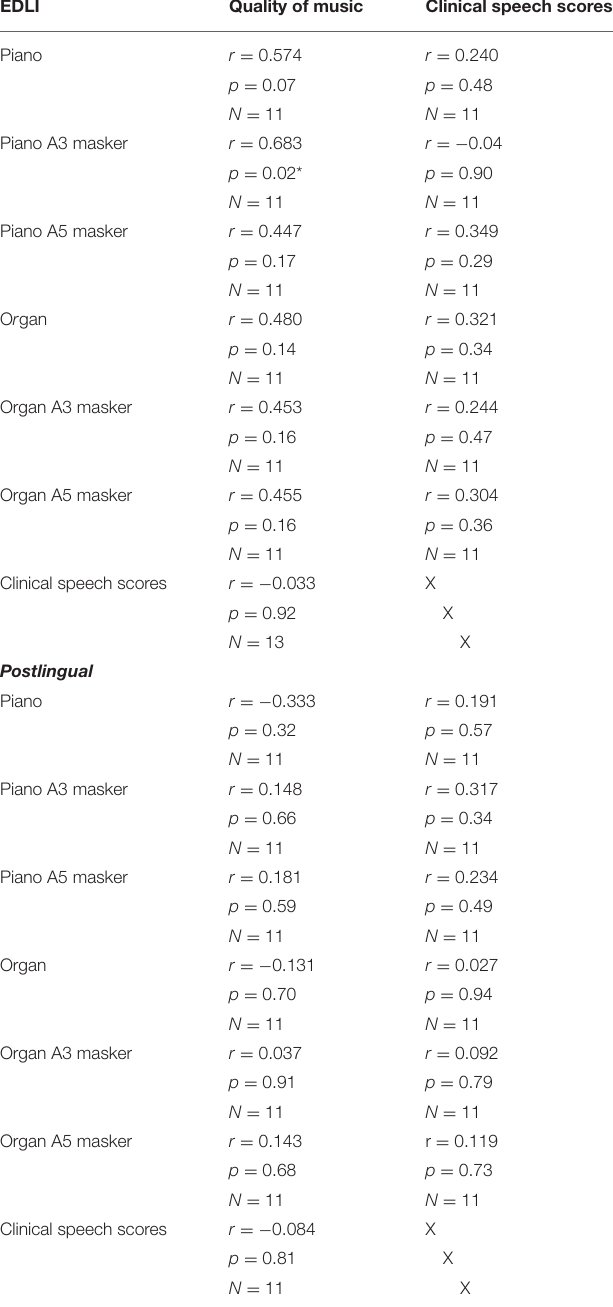
TABLE 5 | Correlational analyses between the subjective outcomes of the quality of music clinical speech scores, and the psychophysical MCI outcomes for both piano and organ, shown for EDLI and control group separately (upper and lower parts, respectively).